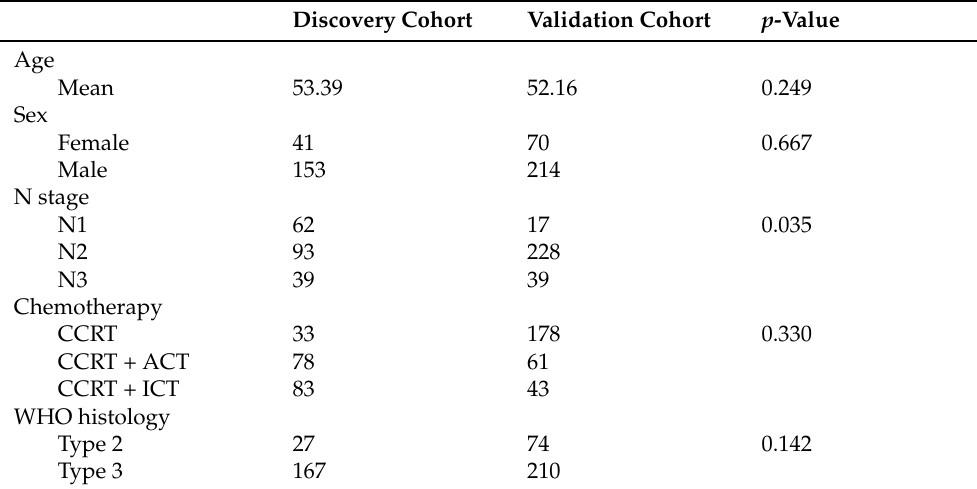
Table 1. Baseline patient characteristics of the discovery and validation